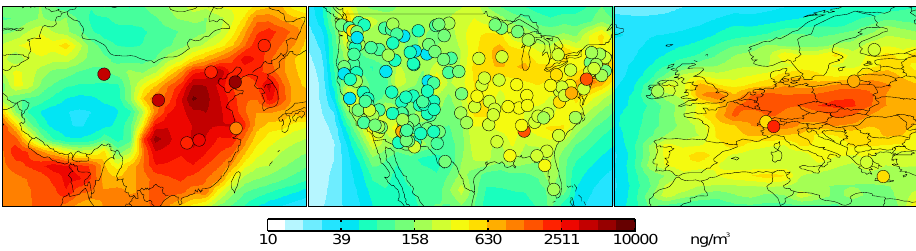
Figure 6. Annual mean surface BC concentrations in China (left), the US (middle) and Europe in the “best” model in 2010 and observations (overlaid with circles). Observations in China are from 2006 except for the sites near Beijing and Shanghai. All the other observations are from 2010.